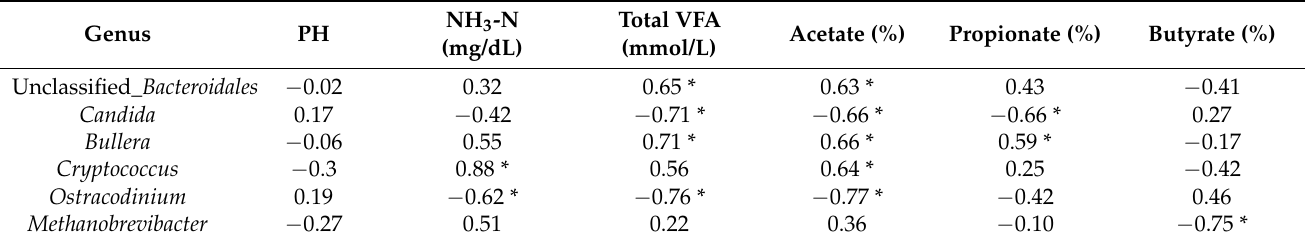
Table 4. Correlations between the predominant ruminal microbiota 1 affected by treatments and rumen fermentation parameters.